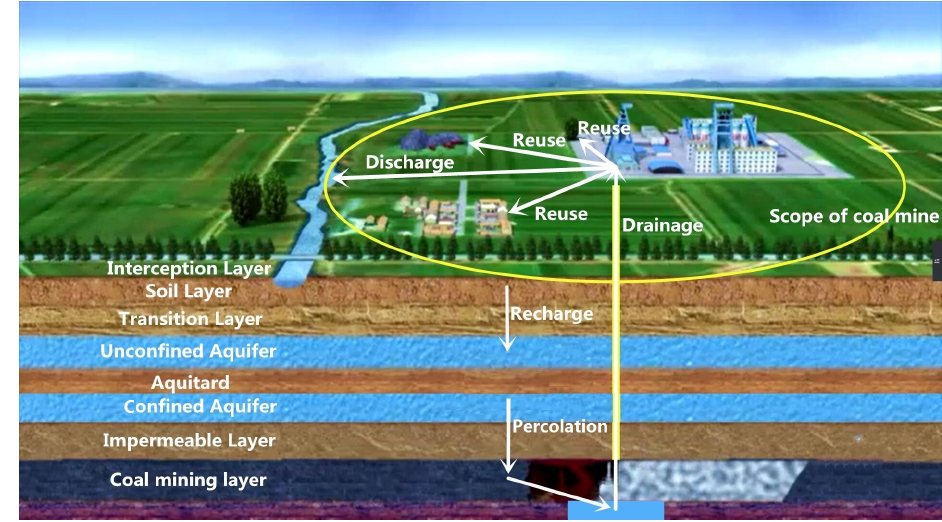
Figure 7. Vertical structure of the WEP-L model after